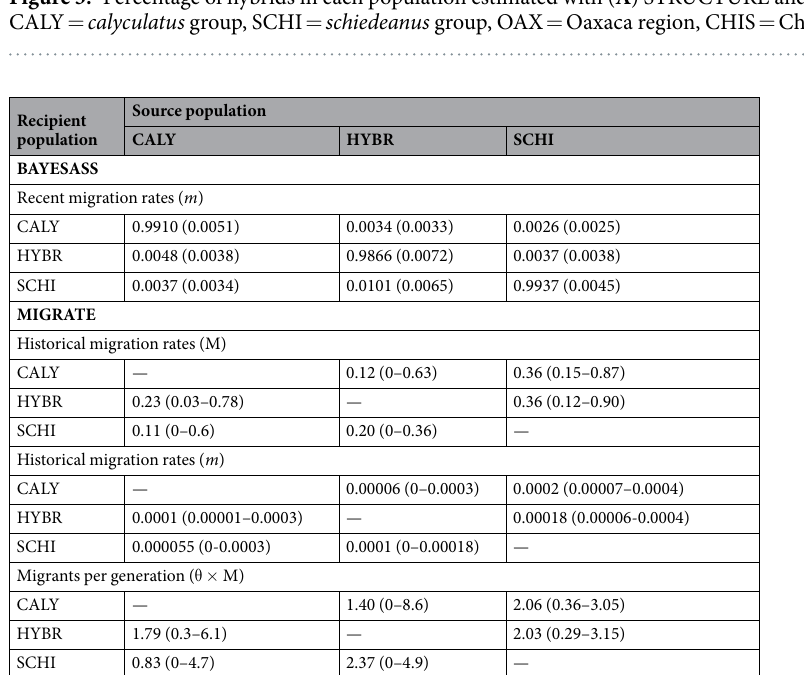
Table 2. Contemporary and historical migration rates estimated with BAYESASS and MIGRATE between the two species (CAL = P . calyculatus , SCHI = P . schiedeanus ) and the hybrid (HYBR) region (OAX = Oaxaca region and CHIS = Chiapas region). CI 95% intervals are given for contemporary migration ( m ). Mean and 25% and 75% posterior distribution percentiles of are given for historical migration (M). Theta values: CALY ( θ 1) = 7.56; HYBRID ( θ 2) = 11.49; SCHI ( θ 3) =